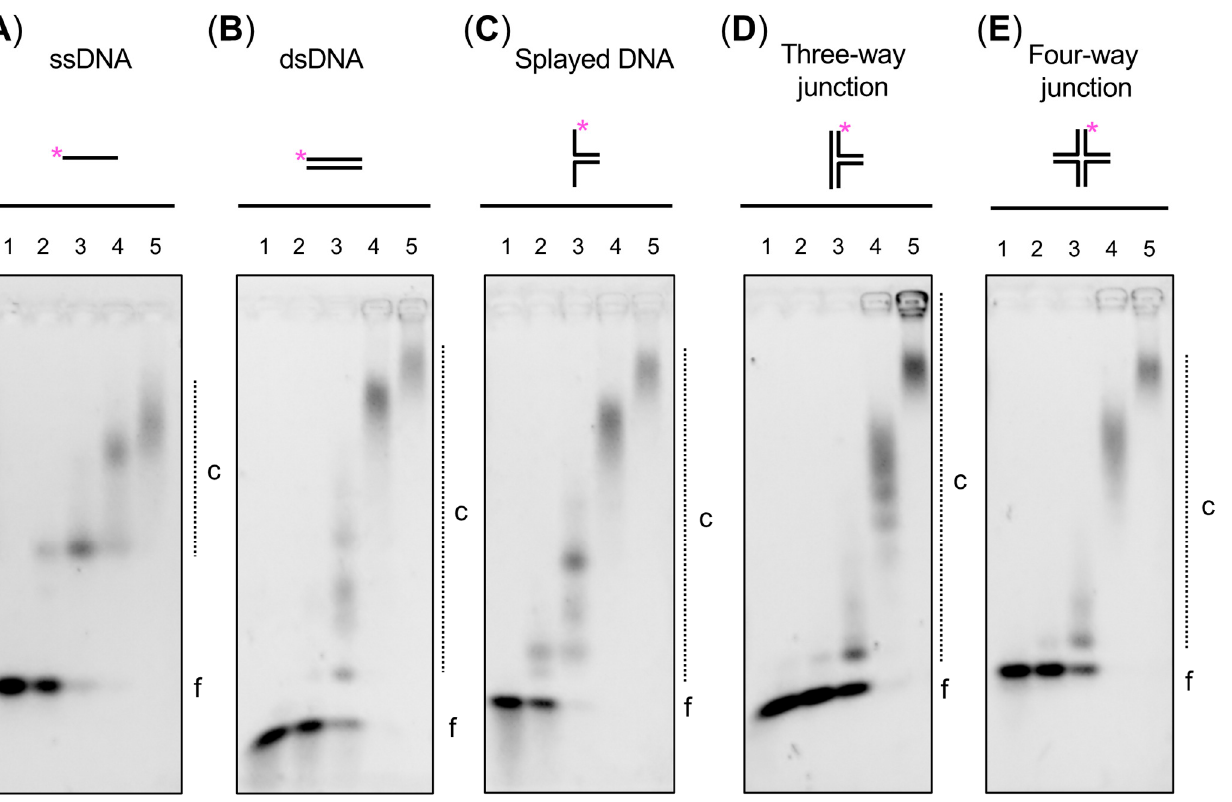
Figure 6. DNA-binding properties of Sac aLhr1. DNA molecules (10 nM) with various structures (ssDNA ( A ), dsDNA ( B ), splayed DNA2 ( C ), Y-junction2 ( D ), and HJS ( E )) were incubated with increasing concentrations of Sac aLhr1 (lane 1, no protein; 2, 60 nM; 3, 110 nM; 4, 230 nM; 5, 450 nM) at 25 °C for 10 min. Asterisks in A–E represent 5 ′ -DyLight 5 labels. Products were separated by 1% or 2% agarose gel in 0.1× TBE. Band assignments are indicated on the side of the panels (c, protein-DNA complexes; f, free DNA). Experiments were repeated thrice, and representative gel images are shown.